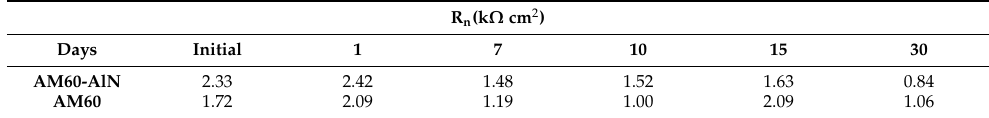
Table 2. Electrochemical noise resistance ( R n ) values of the nanocomposite AM60-AlN and AM60 alloy during their exposure up to 30 days to a simulated marine environment